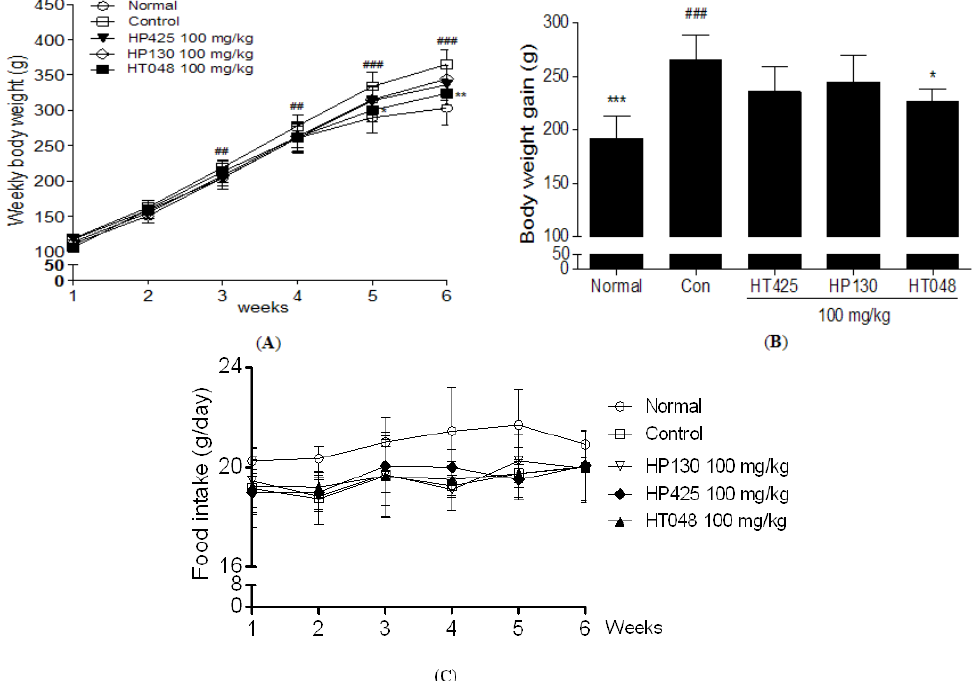
Figure 2. ( A ) Effects of HT048 on body weight (g), ( B ) body weight gain (g) ( C ) and food intake (g/day) in HFD induced obese rat. The body weight of the animals was recorded weekly during the experimental period. The body weight gain was calculated by the equation: final body weight—initial body weight. The food intakes were measured every day. Data are mean ± SD values (n = 10 per group). ### p < 0.001, ## p < 0.01, significant difference from the normal diet group. * p < 0.05, ** p < 0.01, *** p < 0.001, significant difference from the HFD-control group.